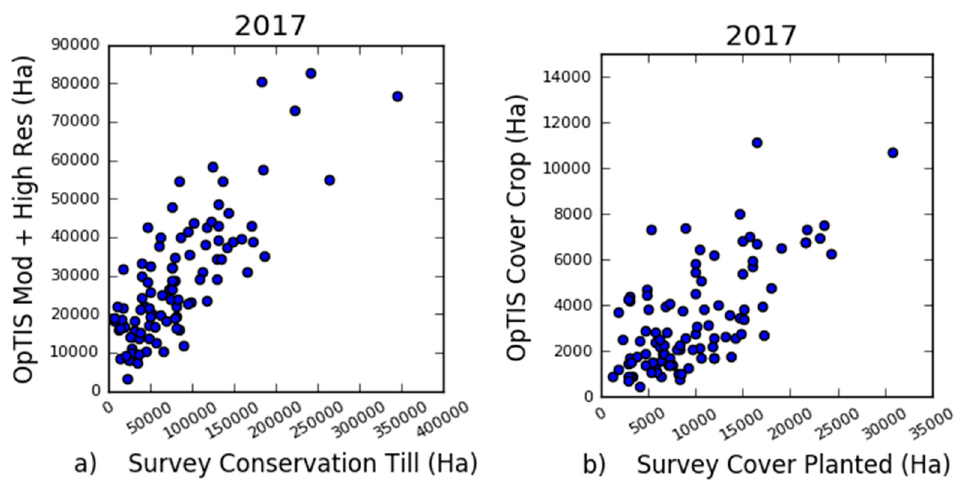
Figure 11. ( a ) OpTIS mapped conservation tillage correlates well with AgCensus reported conservation tillage—0.80 correlation coefficient; ( b ) OpTIS mapped cover crops correlate moderately well with AgCensus reported cover crops—0.67 correlation coefficient.